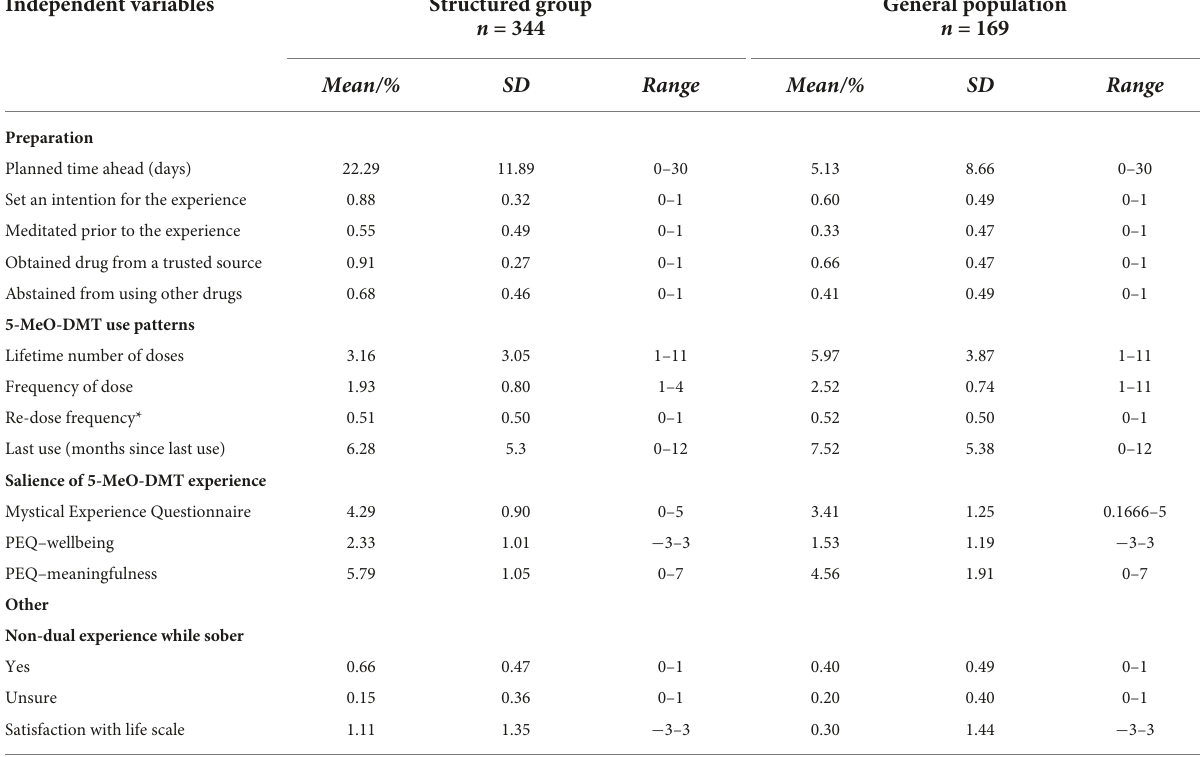
TABLE 2 Distribution of variables by group ( n =